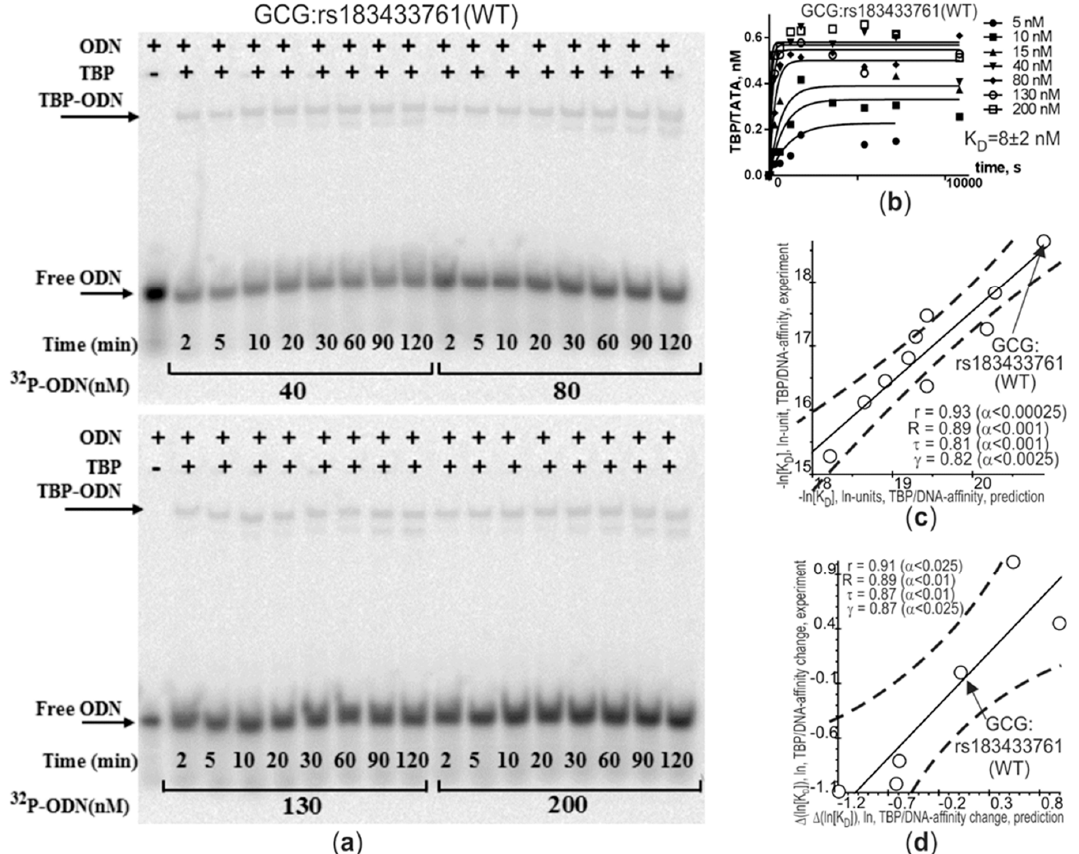
Figure 3. Statistically significant correlations between in silico predicted and in vitro measured values of equilibrium dissociation constant K D of TBP-promoter complexes expressed in ln units. Legend : ( a ) Electropherograms for the wild type ancestral (WT) allele of the unannotated SNP rs183433761 in the human GCG gene promoter as an illustrative example. The concentration of TBP was 0.3 nM in all the experiments. The concentrations of 26 bp oligodeoxyribonucleotides (ODNs) centered around the tested SNP allele are indicated. ( b ) Dependences of reaction rates on ODN concentrations in cases of the ancestral alleles of the SNP in question. The KD value of the equilibrium dissociation constant was inferred from these dependences serving as input data for publicly available software GraphPad Prism 5 (http://graphpad-prism.software.informer.com/5.01). ( c , d ) Graphical representation of the analyzed correlations on absolute and relative measurement scales, respectively. Solid and dashed lines denote linear regression and boundaries of its 95% confidence interval, calculated by means of software package STATISTICA (Statsoft TM , Tulsa, USA). Arrows pinpoint the ancestral (WT) alleles of the SNP being studied (GCG:rs183433761). Statistics: r, τ , γ , and p are coefficients of Pearson’s linear correlation, Spearman’s rank correlation, Kendall’s rank correlation, and Goodman–Kruskal generalized correlation and their p -values, respectively.